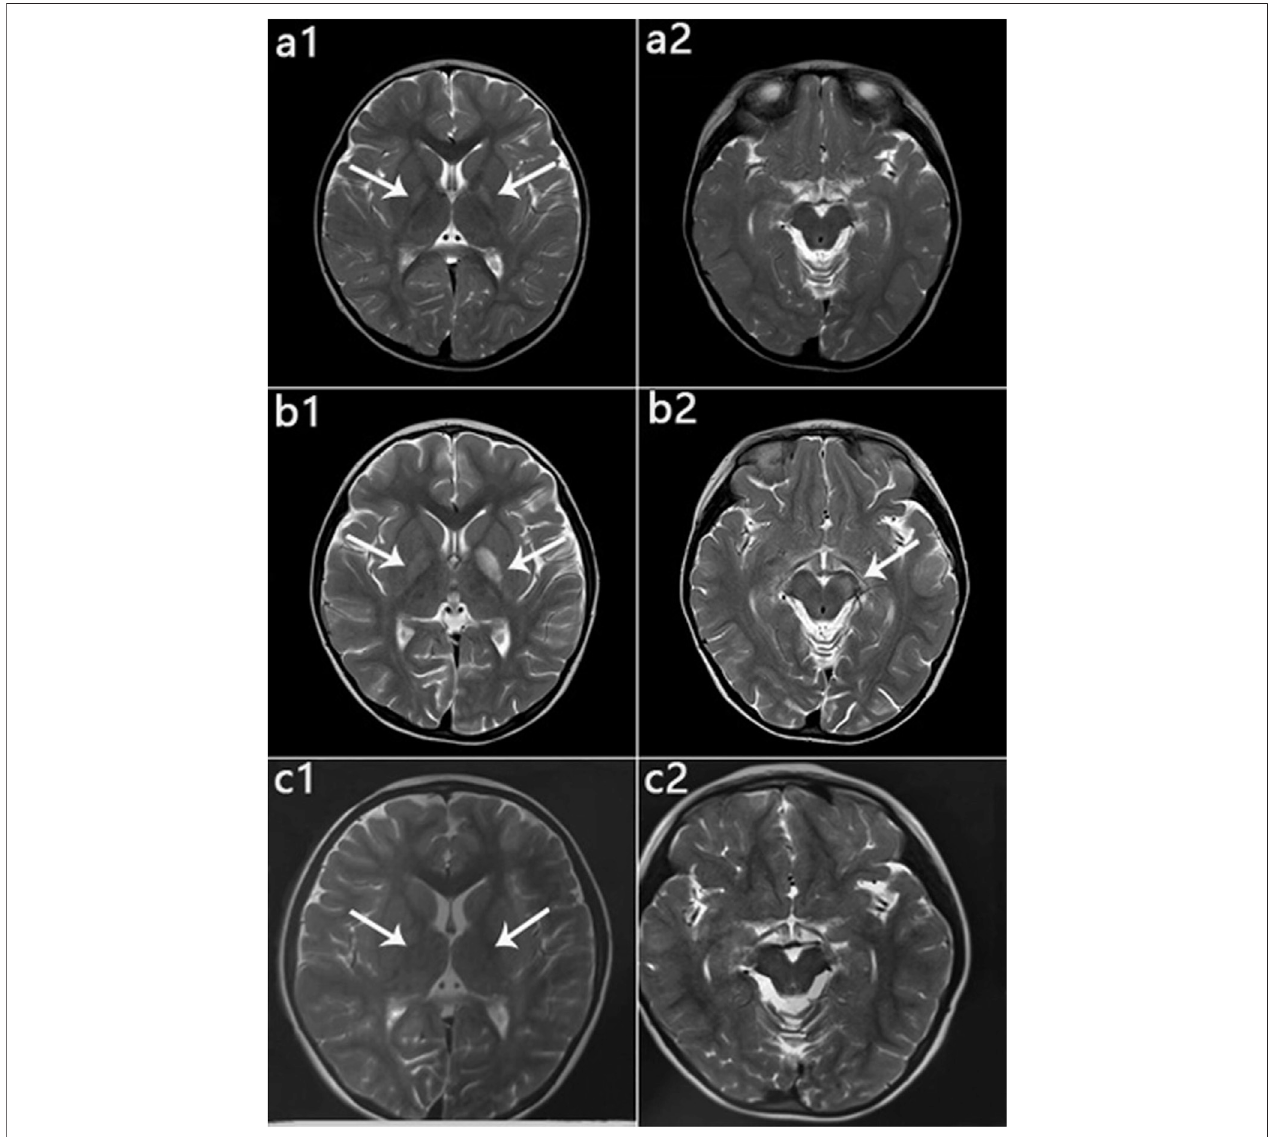
FIGURE6| Patient 1:MRIperformanceinthepeak and recoveryphases. (a1,a2): InitialMRI obtainedat age2 years;hyperintensity onT2WIintheglobus pallidus (a1), normal cerebral peduncle (a2). (b1, b2): MRI performed at 4 years 5 months during the acute stage; hyperintensity on T2WI in the globus pallidus with swelling on theleftside(b1)andintheleftcerebralpeduncle(b2).(c1,c2):MRIperformedat6 years1 monthduringtherecoverystage;onlyslightlyhyperintensityonT2WIinglobus pallidus (c1), and Abnormal signal disappeared in the cerebral peduncle (c2).